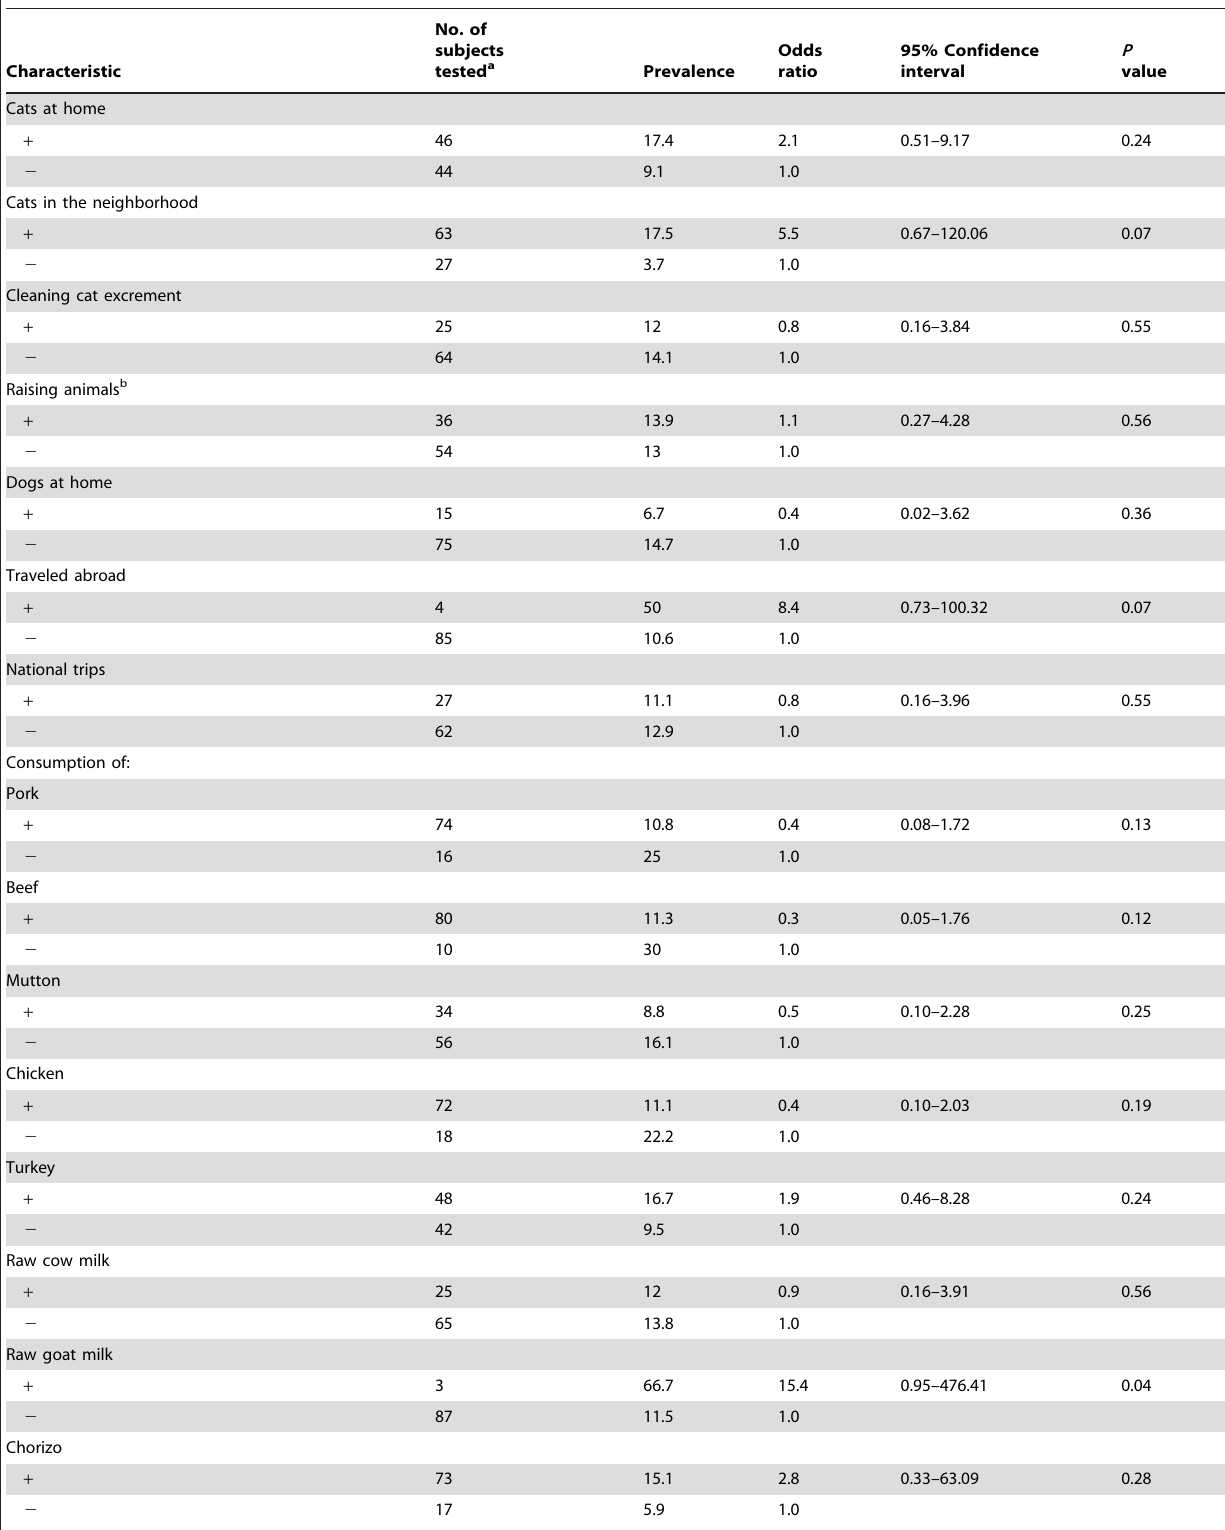
Table 3. Seroprevalence (%) of toxocaral infection in waste pickers relative to bivariate analysis of food consumption, feeding habits and other behavioural